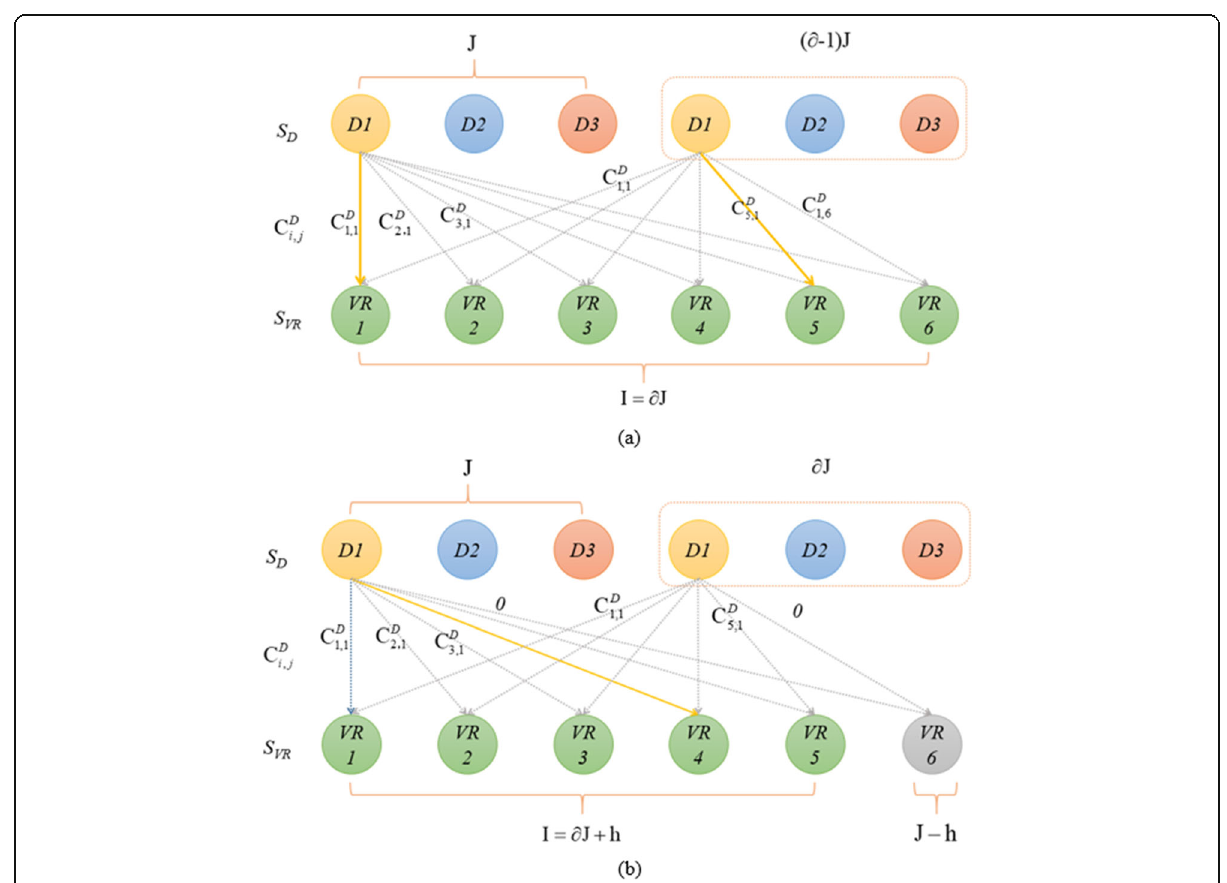
Fig. 3 Bipartite matching of D j multiplexed VR i channels. a Matching in the case of I = ∂ × J . b Matching in the case of I = ∂ × J +